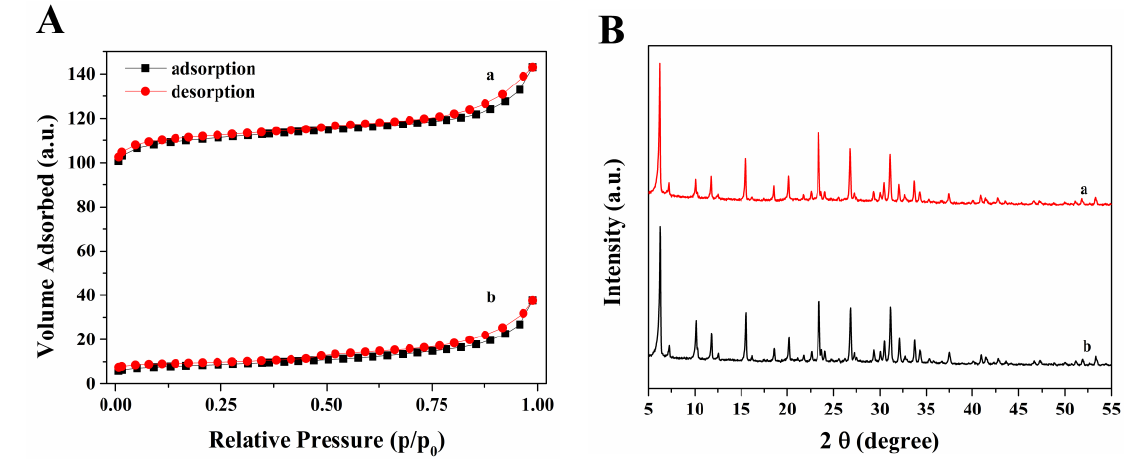
Figure 2. ( A ) Nitrogen adsorption-desorption isotherms and ( B ) X-ray diffraction patterns (XRD) patterns of (a) CaX, (b) IL/CaX.